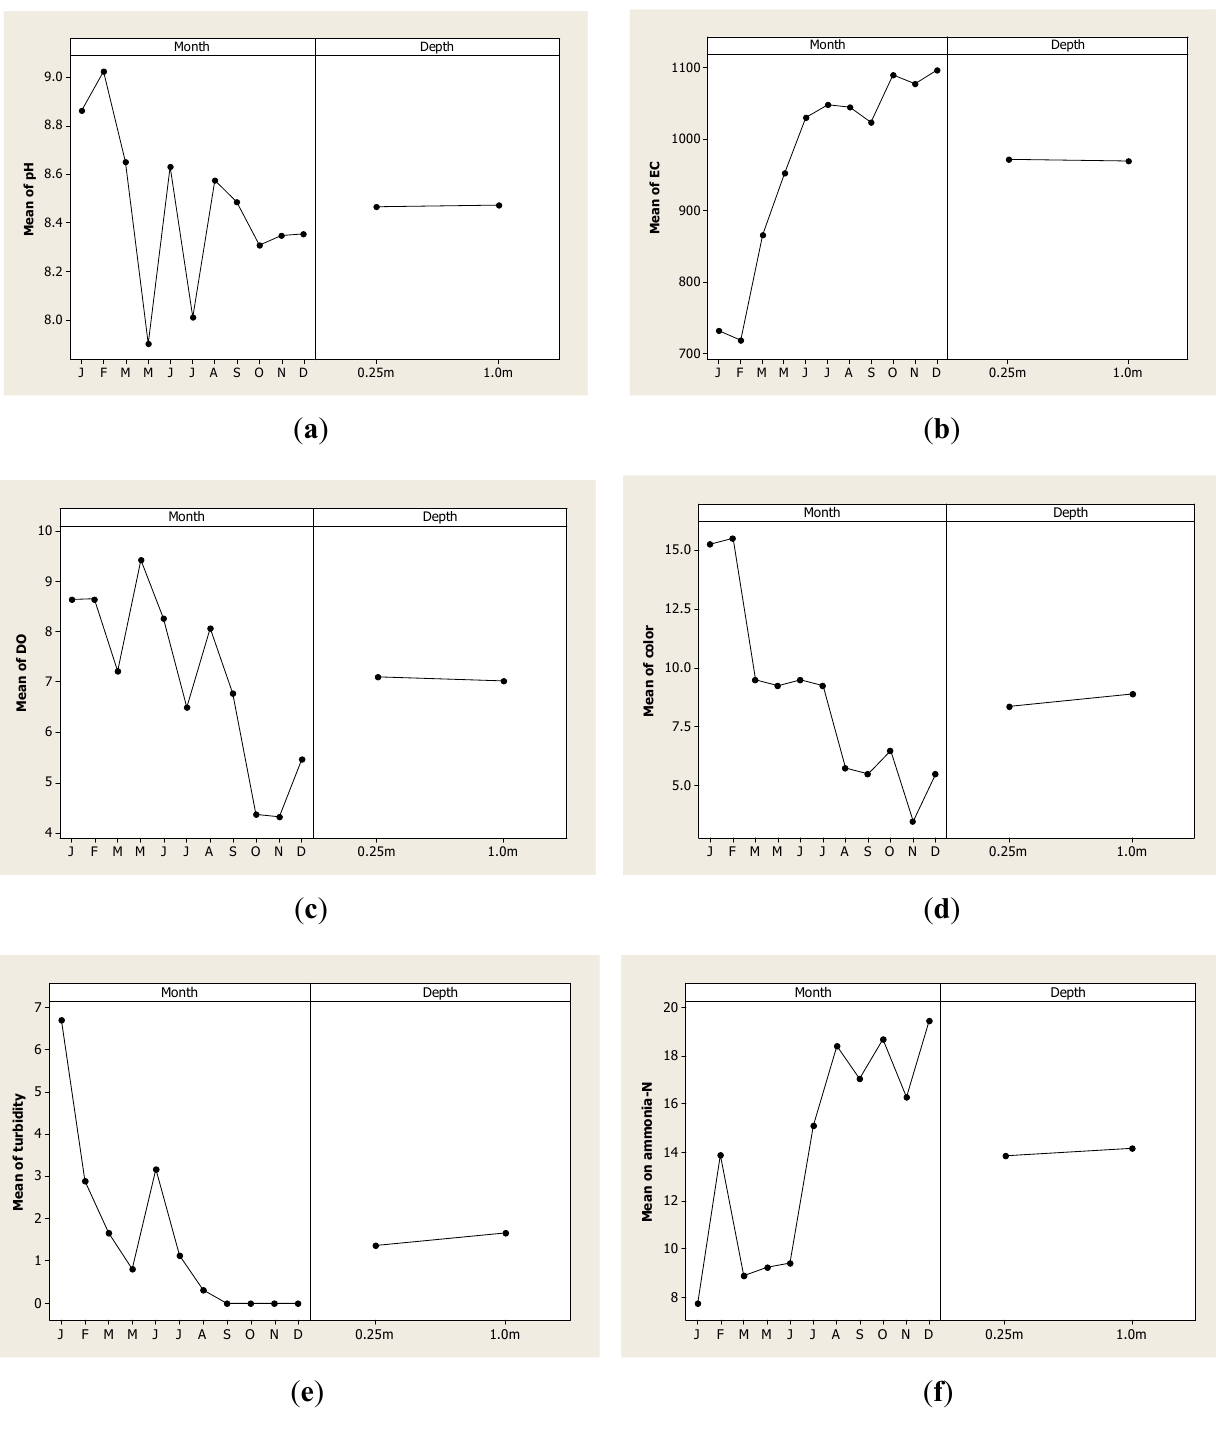
Figure 2. Level of the parameters pH, EC, OD, color, turbidity and ammonia-N detected in water samples of the Luis L. Leon dam in Chihuahua,